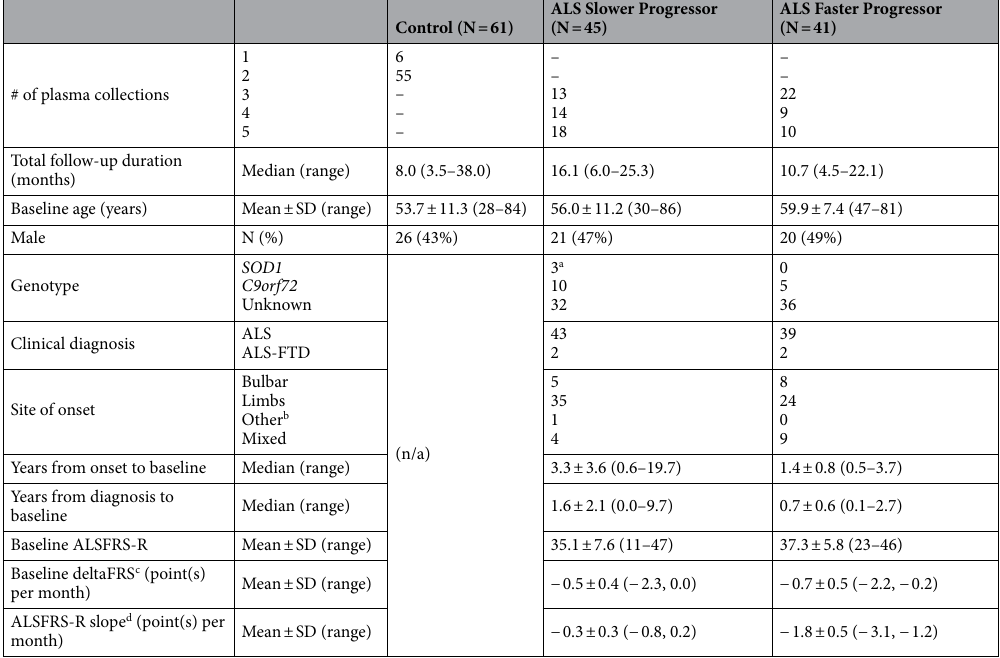
Table 2. Study participant characteristics. Baseline = first visit at which plasma sample was available. Total follow-up duration = time between the participant’s first and last plasma sample included in this study. (n/a) = not applicable. a The 3 SOD1 variants were A89V, E100K, and E121G. b Site of onset other than bulbar or limbs (e.g. frontotemporal, respiratory). c ALSFRS-R rate of decline from time of onset (assuming ALSFRS-R = 48) to baseline; negative value indicates decline. d Negative value indicates decline.